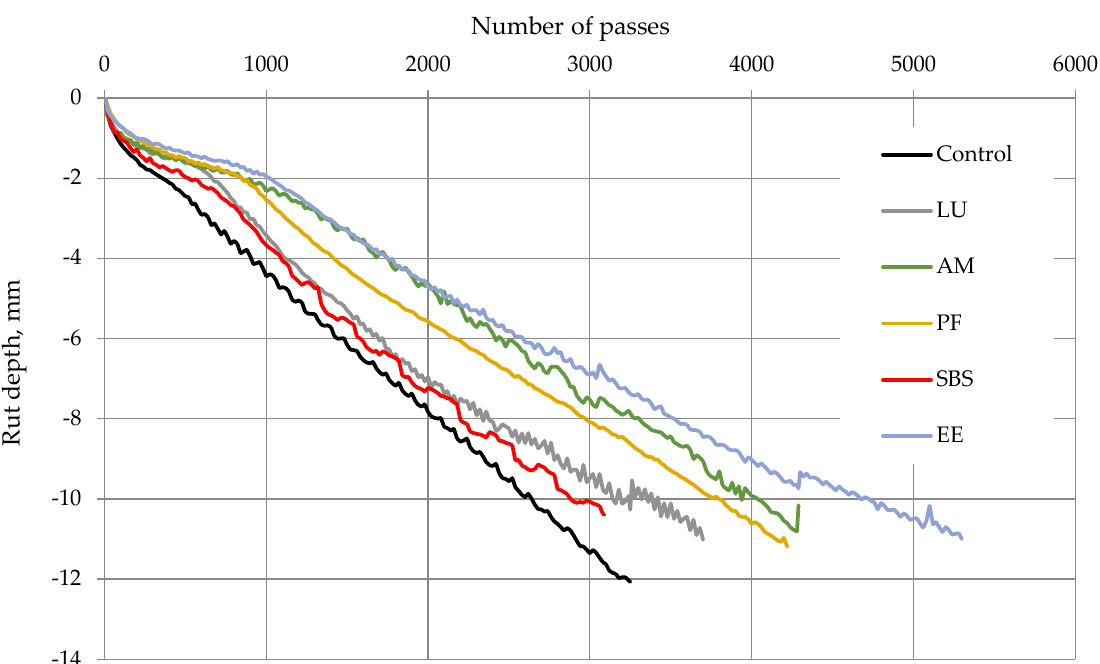
Figure 11. Rut depth versus the number of passes for different mixtures.